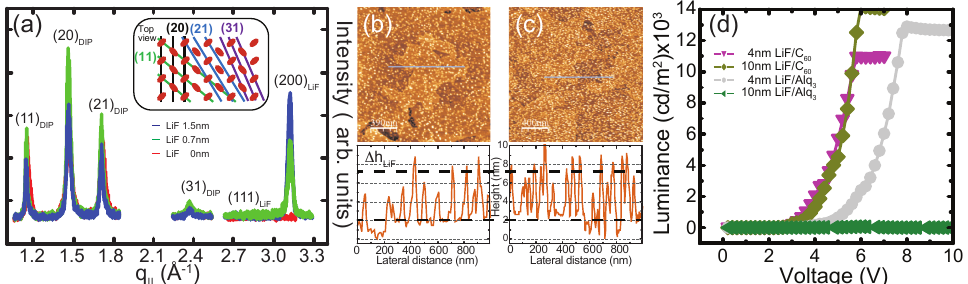
Figure 4. Thickness dependent LiF deposition on top of planar monolayer (ML) by monolayer grown di–indenoperylene (DIP) ( a ) GIXRD data support the formation of crystalline nanoparticles on well or- dered organic molecules without disrupting the crystalline packing. Centre positions of the observed in-plane peaks were fitted with Lorentzian functions. Inset shows the schematic arrangement in the observable crystallographic planes in real space for DIP herring bone structure and LiF FCC structure. ( b ) AFM micrographs of low coverage ( ∼ 7 Å) and ( c ) high coverage ( ∼ 15 Å) show the LiF islands formed on top of the large flat plateau islands of DIP. Height profile beneath corresponds to the line in the AFM micrograph, showing height steps between different DIP layers and peaked height fluctuations (20–70 Å) due to LiF. Reproduced with permission from Ref. [62]. ( d ) Luminance–voltage (L–V) characteristics of multilayer OLED device with Alq 3 and NBB (C 60 ) electron transporting layers with relatively thick LiF layers, which form a complete layer on top of the organic molecule. Though 10 nm completely blocks emission from Alq 3 based devices, the emission characteristics are unchanged for the NBB layer. Device structure glass/ITO/NPB(60 nm)/Alq(25 nm)/NBB(0 or 20 nm)/LiF (4 or 10 nm)/Al(150 nm). Reproduced with permission from Ref.